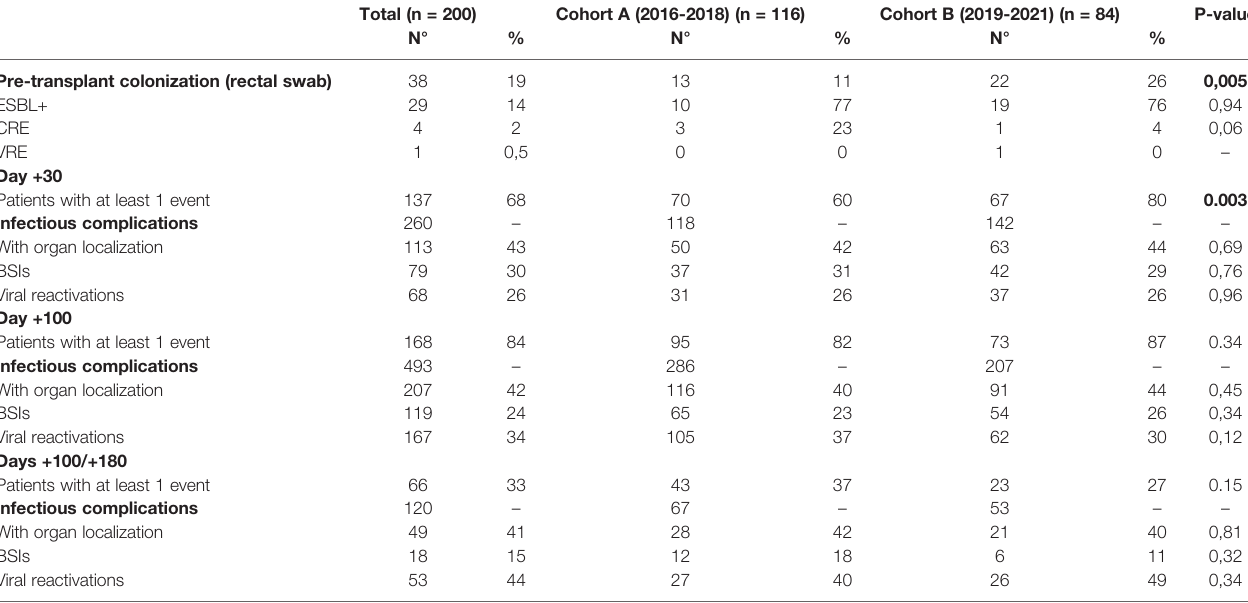
TABLE 3 | Distribution of pre-transplant colonization and infectious complications in the 200 allotransplanted patients of this analysis. Total (n =